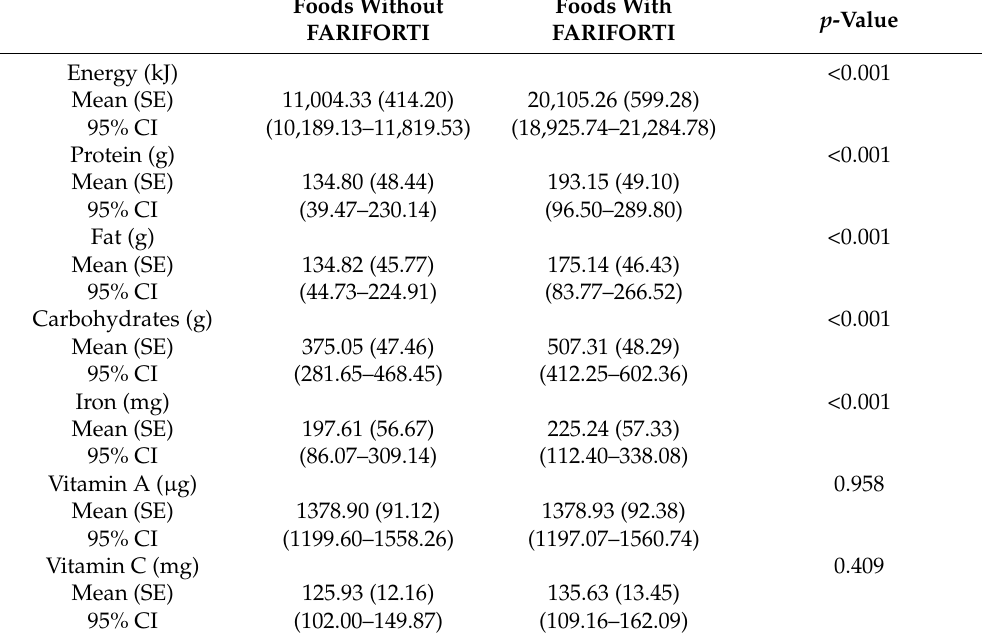
Table 3. Energy and nutrient intakes during the foods consumed by the children in LNR centers with and without the FARIFORTI porridge ( n = 289) .